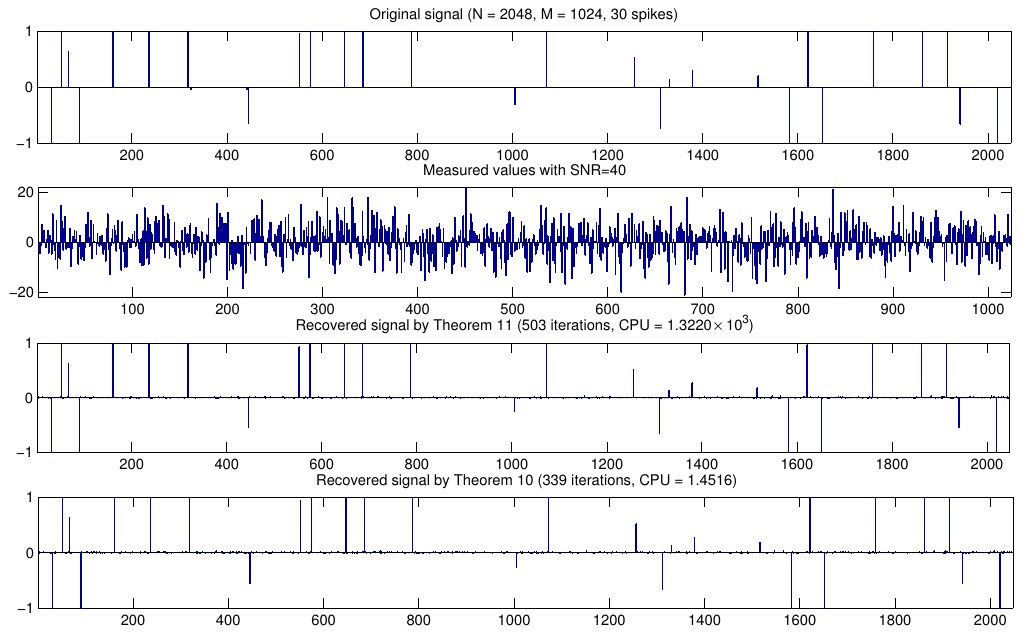
Figure 4. From top to bottom: original signal, measured values, recovered signal by Theorem 11 and Theorem 10 with N = 2048, M = 1024 and m =